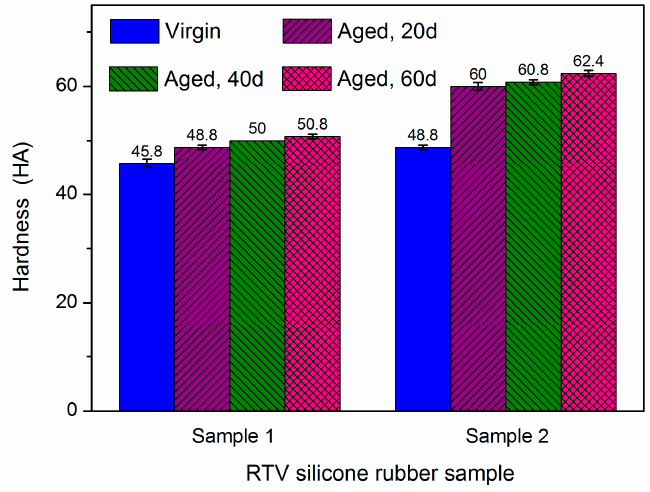
Figure 7. Hardness of virgin samples and aged samples at different aging times.